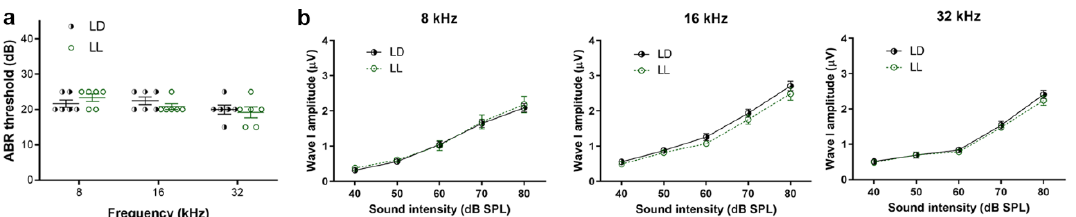
Figure 2. The ABR (auditory brainstem response) thresholds and wave I amplitudes in the LD and LL groups. ( a ). The ABR thresholds in the LD and LL groups. ( b ). Wave I amplitudes at sound intensities of 40 to 80 dB in the LD and LL groups at 8, 16, and 32 kHz. There were no significant differences in ABR thresholds and wave I amplitudes between the LD and LL groups. Data are mean ± SEM ( n = 6 for each group).